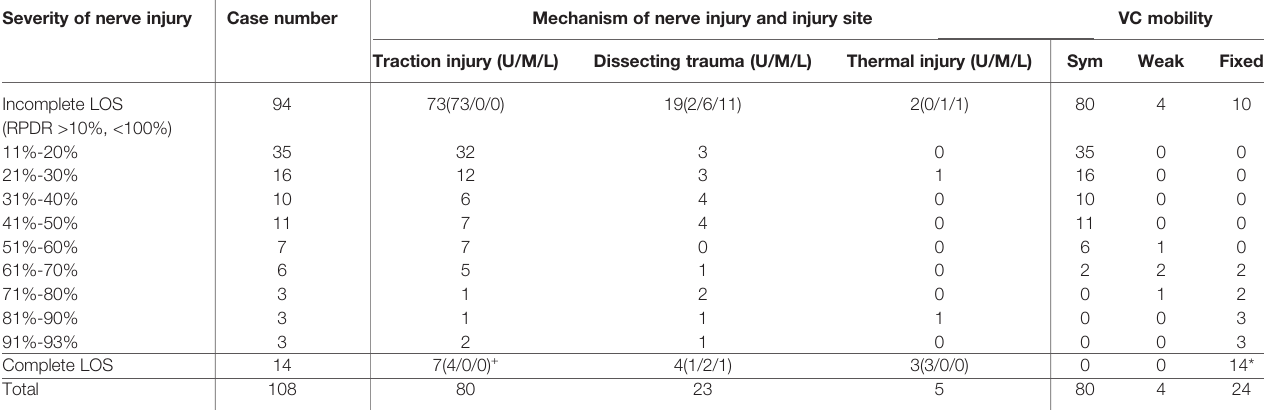
TABLE 2 | The mechanism and severity of RLN injury and the outcome of VC mobility in 108 RLNs detected with injury. Severity of nerve